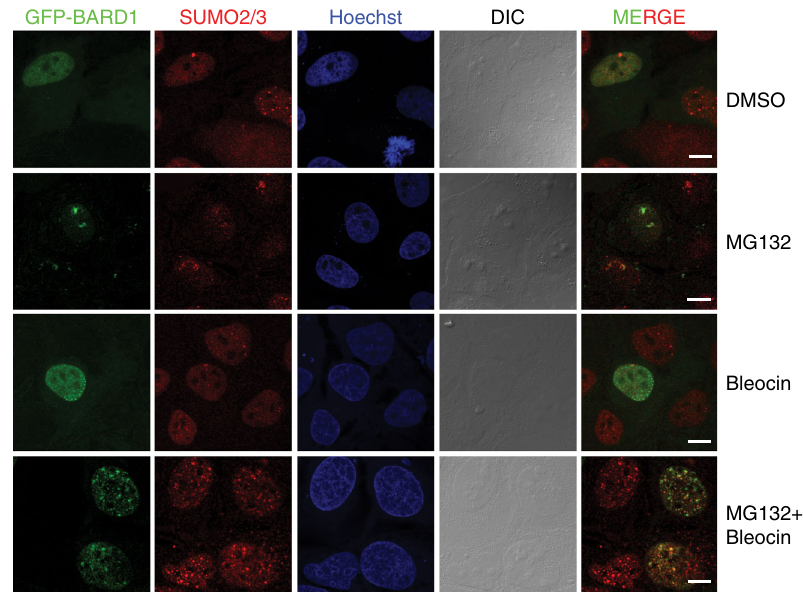
Fig. 8 Co-localization of BARD1 and SUMO2/3 in response to DNA damage and proteasome inhibition. U2OS cells were transfected with a GFP-BARD1 (green) expression plasmid. Two days after transfection, the cells were treated with DMSO, MG132 (10 µ M), and/or Bleocin (5 µ g/ml) for 6 h as indicated. The cells were fi xed and stained with Hoechst (blue) and for endogenous SUMO2/3 (red). The cells were analyzed by confocal microscopy. Three biological replicates were performed. Scale bars represent 10 μ